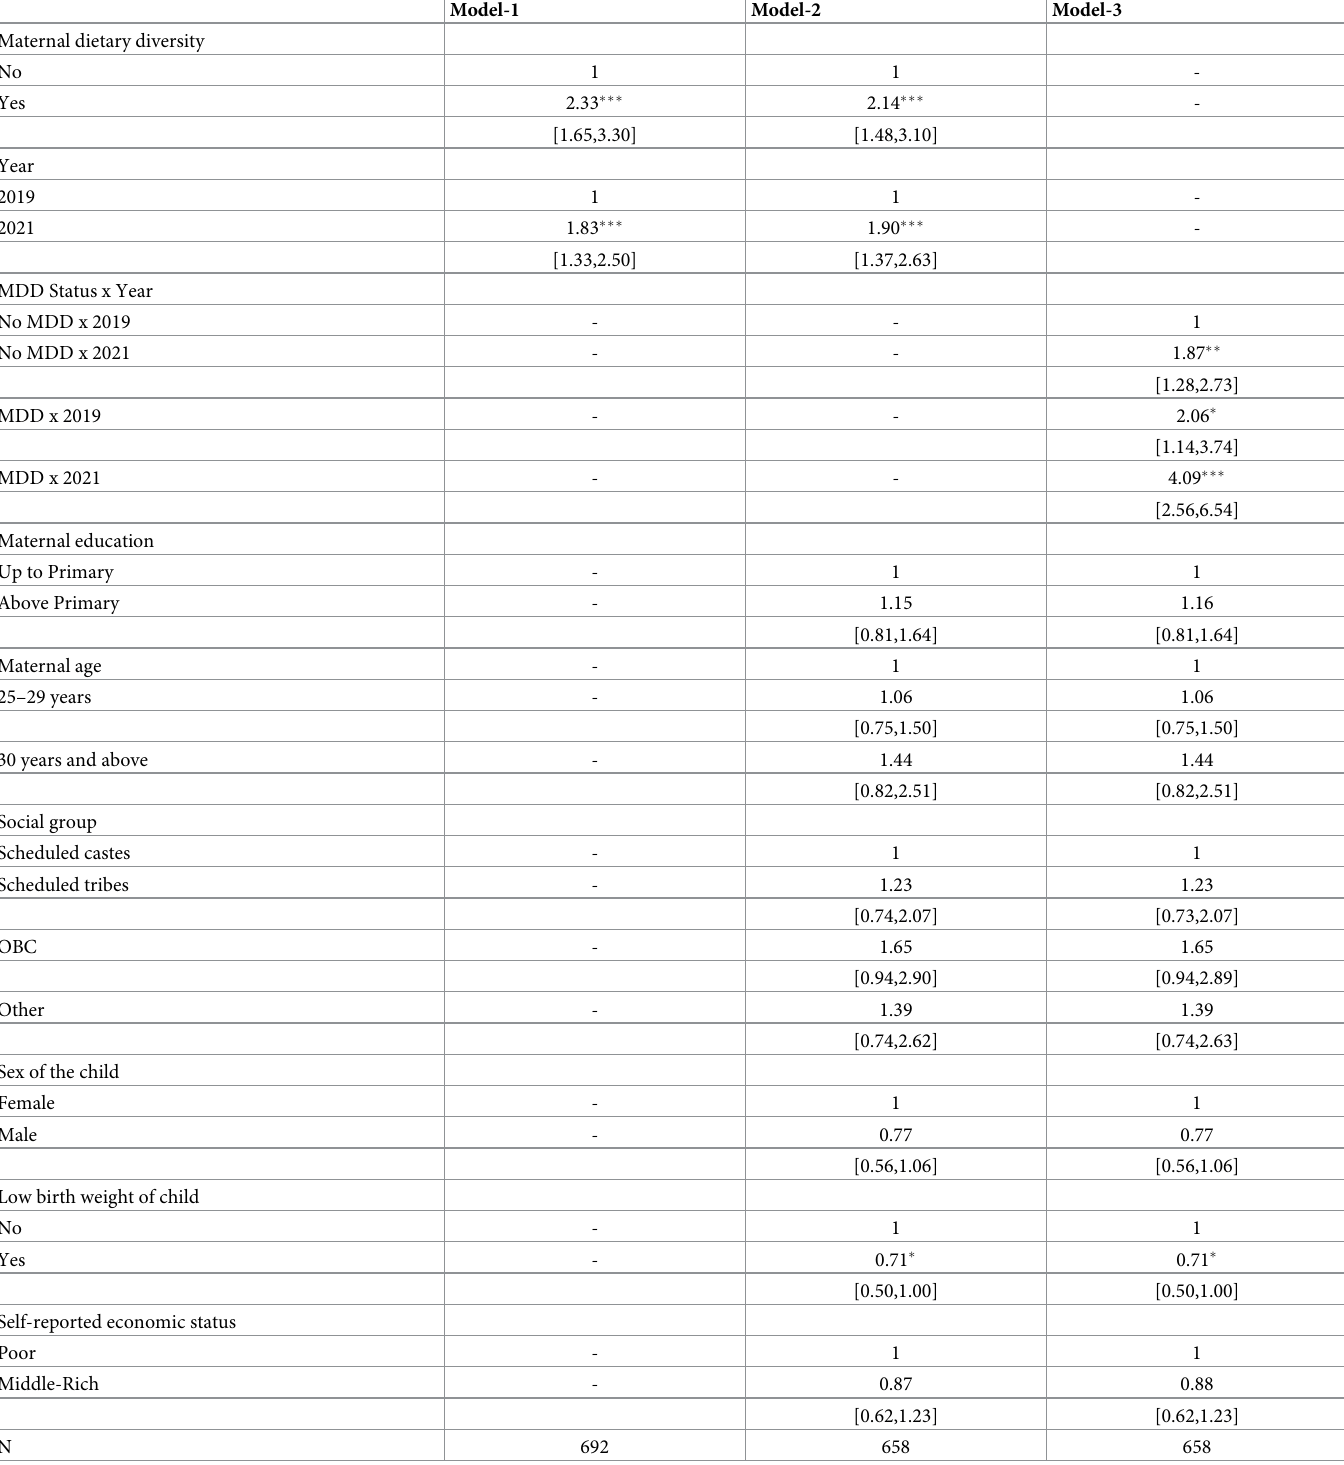
Table 5. Logistic regression based odds ratio for the association between maternal and child dietary diversity and role of Project Spotlight, Gadchiroli and Chandra- pur, 2019 and